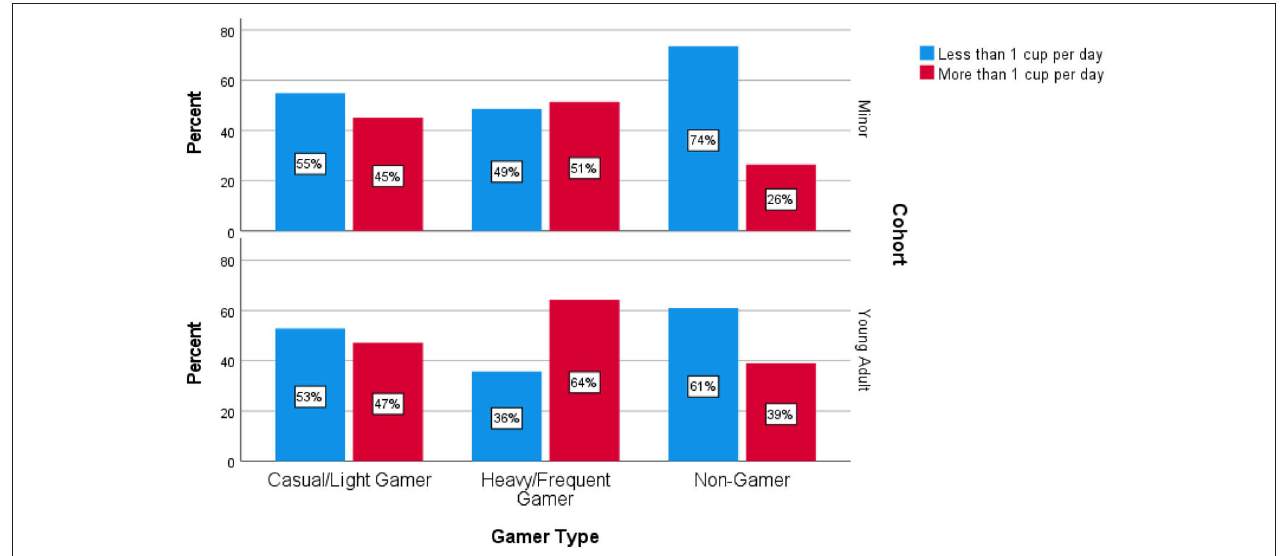
FIGURE 4 | Softdrink consumption among minors and young